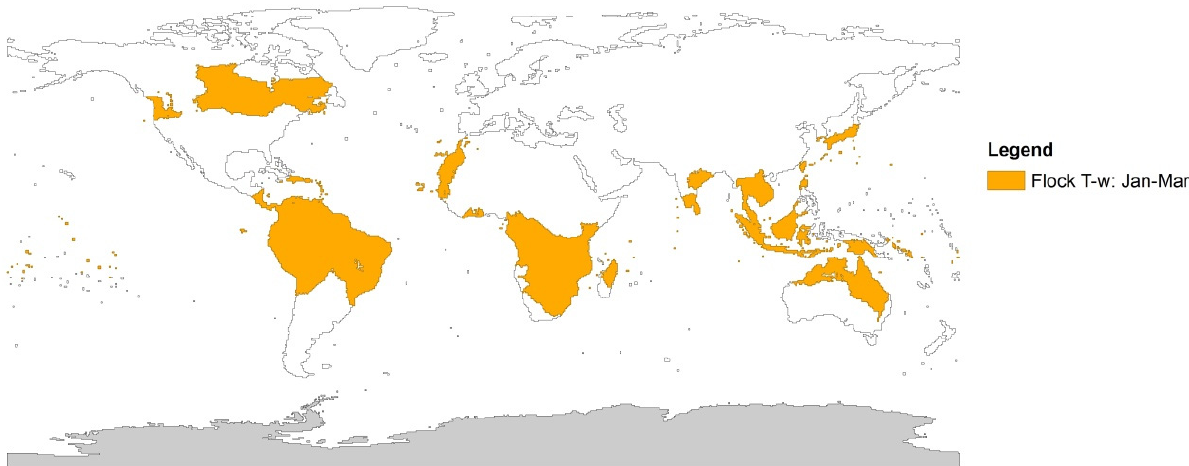
Figure 1. An example of a flock. The yellow regions show the coverage of the flock. The legend of the flock indicates the variable (T), teleconnection type (w) and the period of the flock (Jan-Mar). Note that this flock (and all the other flocks in this paper) is based on the CRU TS v4.02 dataset.